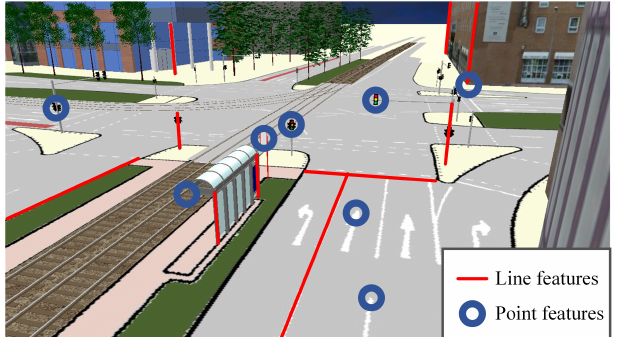
Figure 3. Illustration of road features. Red lines represent line features for localization reference; blue circles represent point